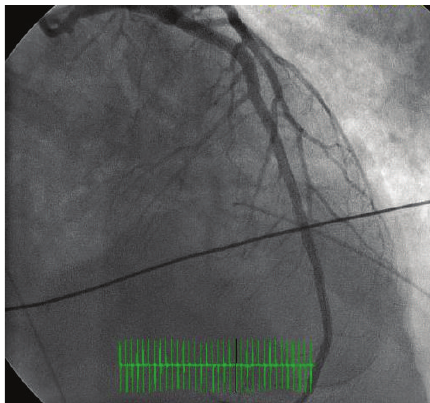
Figure 4: Left heart catheterization image postimplantation of two overlapping drug eluting stents, depicting TIMI 3